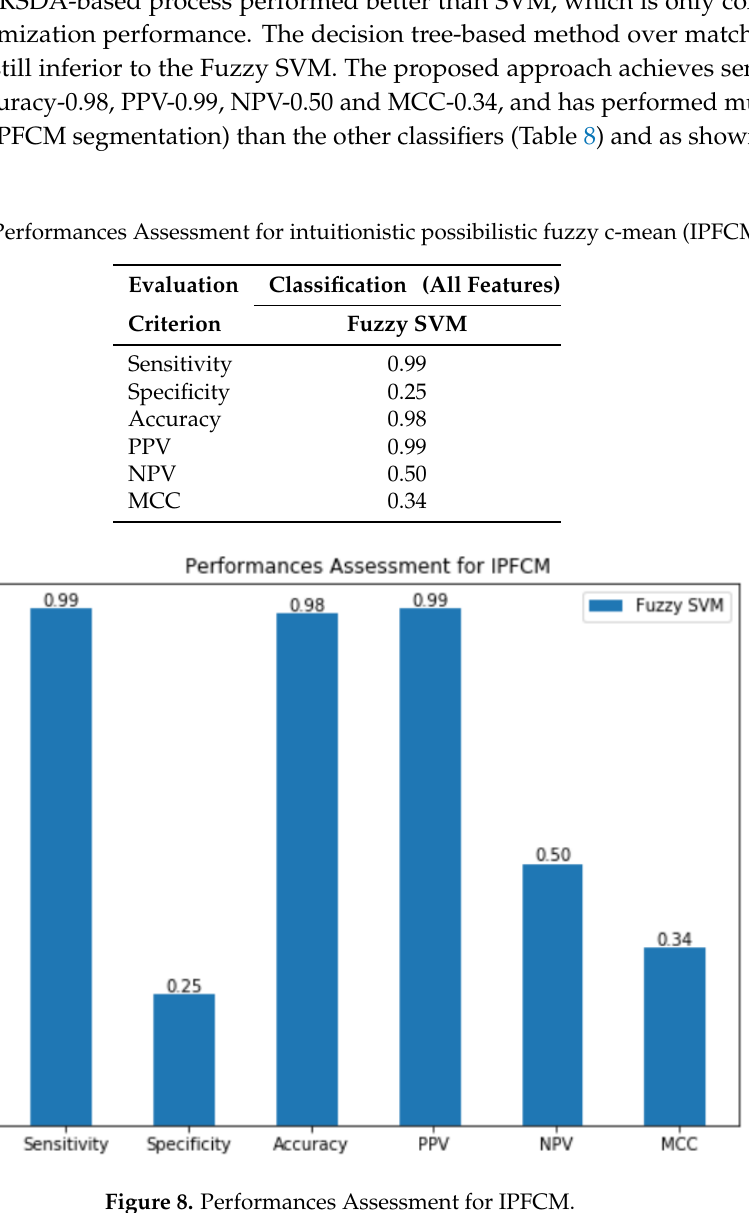
Figure 8. Performances Assessment for